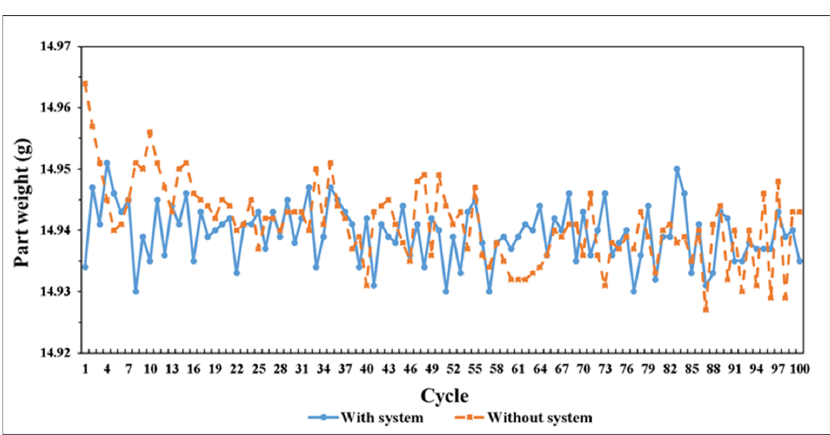
Figure 24. Distribution of part weight in experiment.